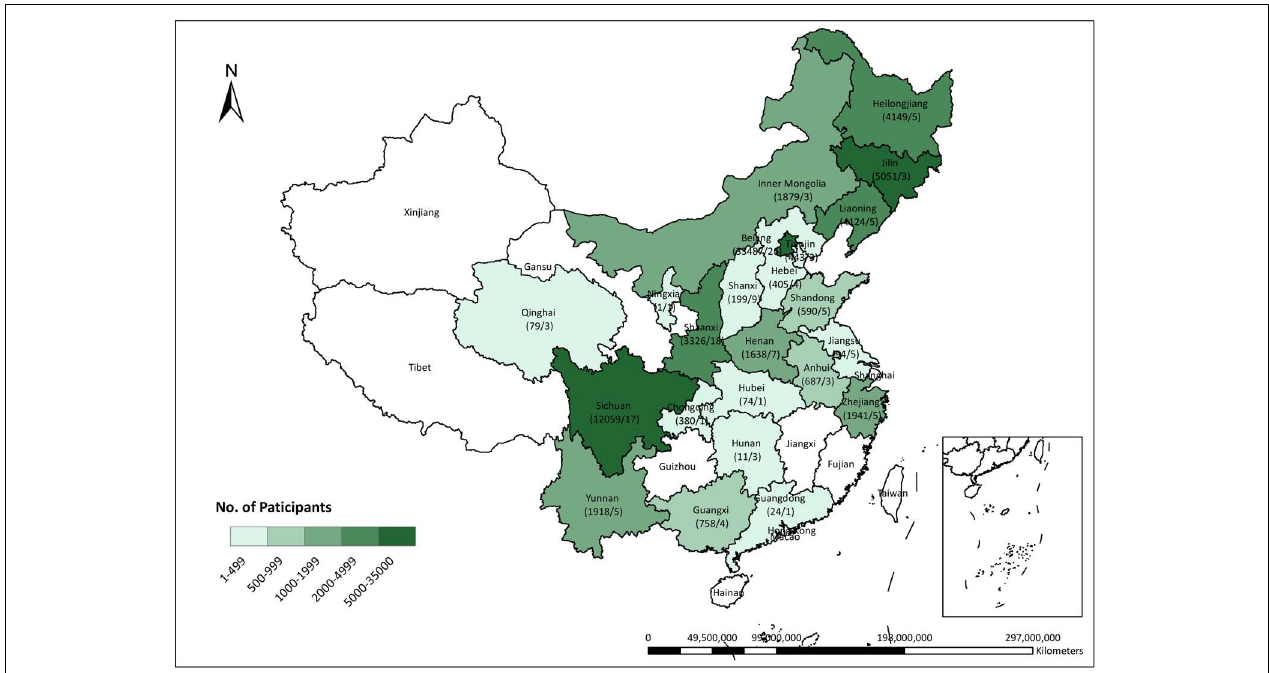
FIGURE 1 | Distribution of participants across China. The numerator denotes the number of pregnant women who were included in this study cohort and the denominator denotes the number of hospitals as the research centers recruiting the participants.